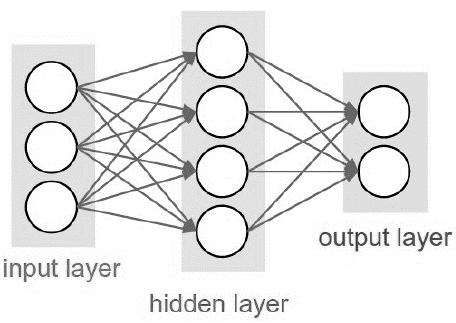
Figure 1. Feed forward neural network (FFNN) model topology with single hidden layer.